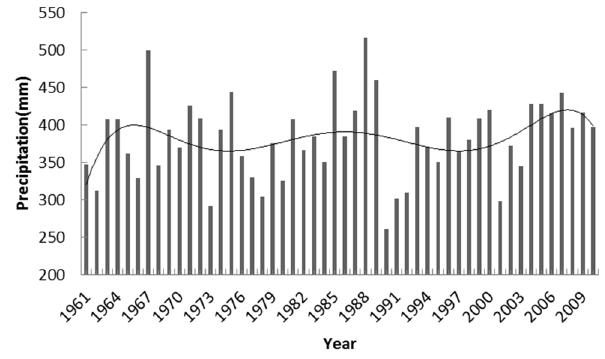
Figure 5. Annual precipitation change in Qinghai Lake basin from 1961 to 2010.